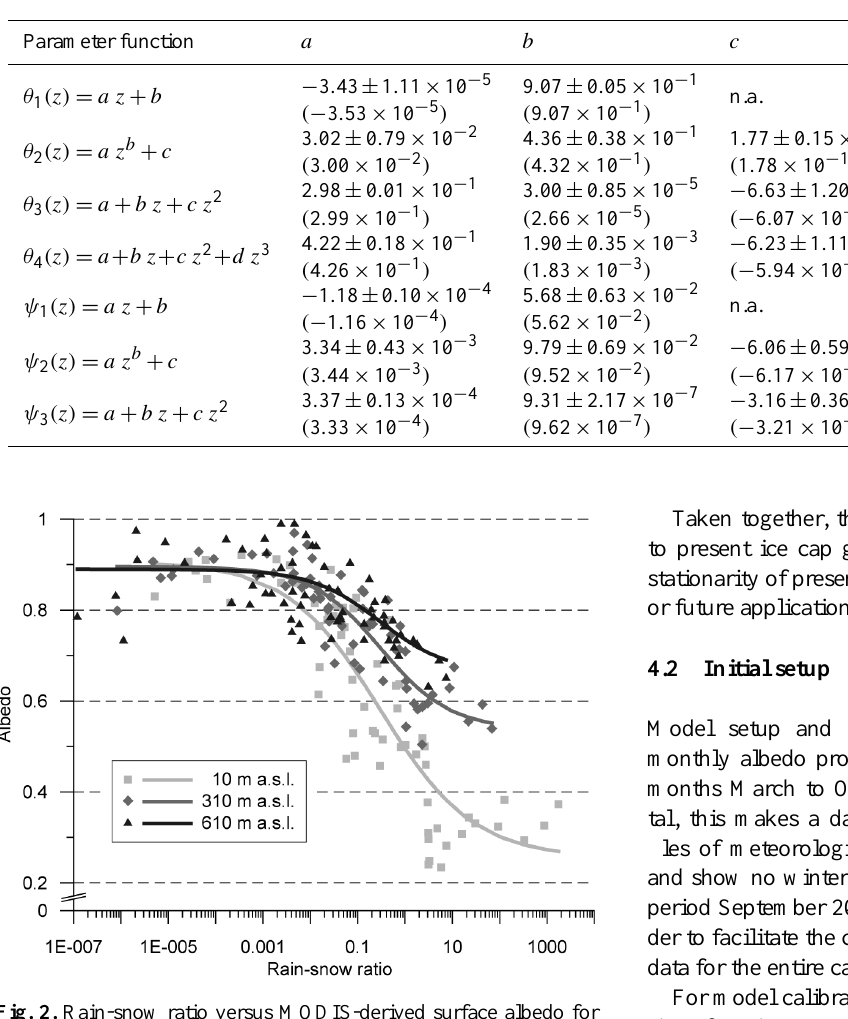
Table 2. Description of the parameter functions θ 1 − 4 (z) and ψ 1 − 3 (z) of the albedo model (Fig. 3) that are employed in Eqs. (10) and (11). The parameters of the parameter functions ( a , b , c , d ) are given for the FAM (mean ± one standard deviation) and the IAM (value in parenthesis). The parameter functions are fitted to the respective individual parameter values that are obtained for the 31 elevation bins. The coefficients of determination ( R 2 ) of the parameter functions are also given for the FAM and for the IAM (value in parenthesis).